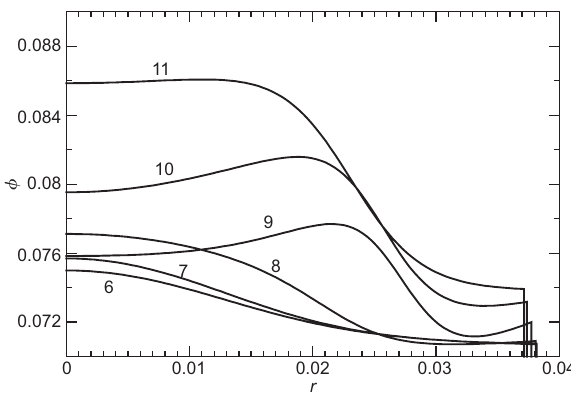
Figure 10 Profi le of φ , the polymer volume fraction during p DESWELLING for the sequence of times (6–11) defi ned in Figures 5 and